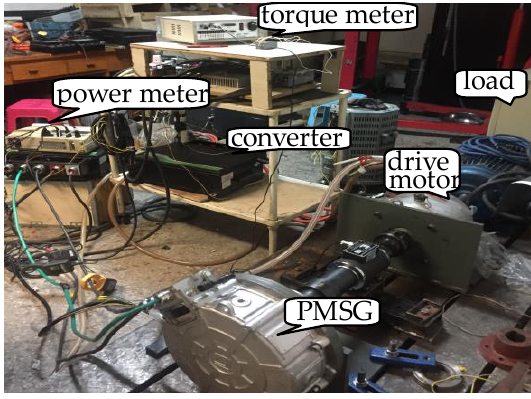
Figure 16. The test bench for RE power generation system.